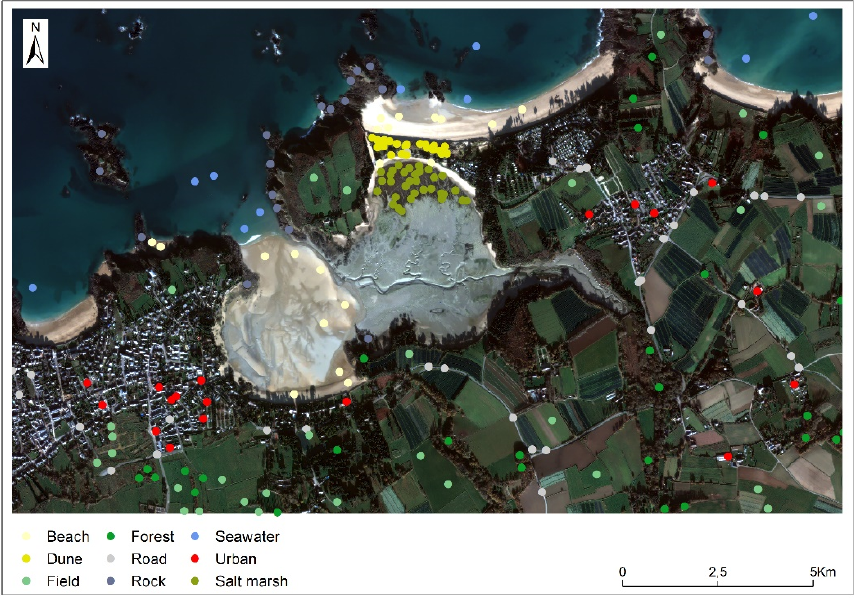
Figure 4. Natural–coloured nadiral Pleaide–1 imagery with the calibration/validation class loca- tions.